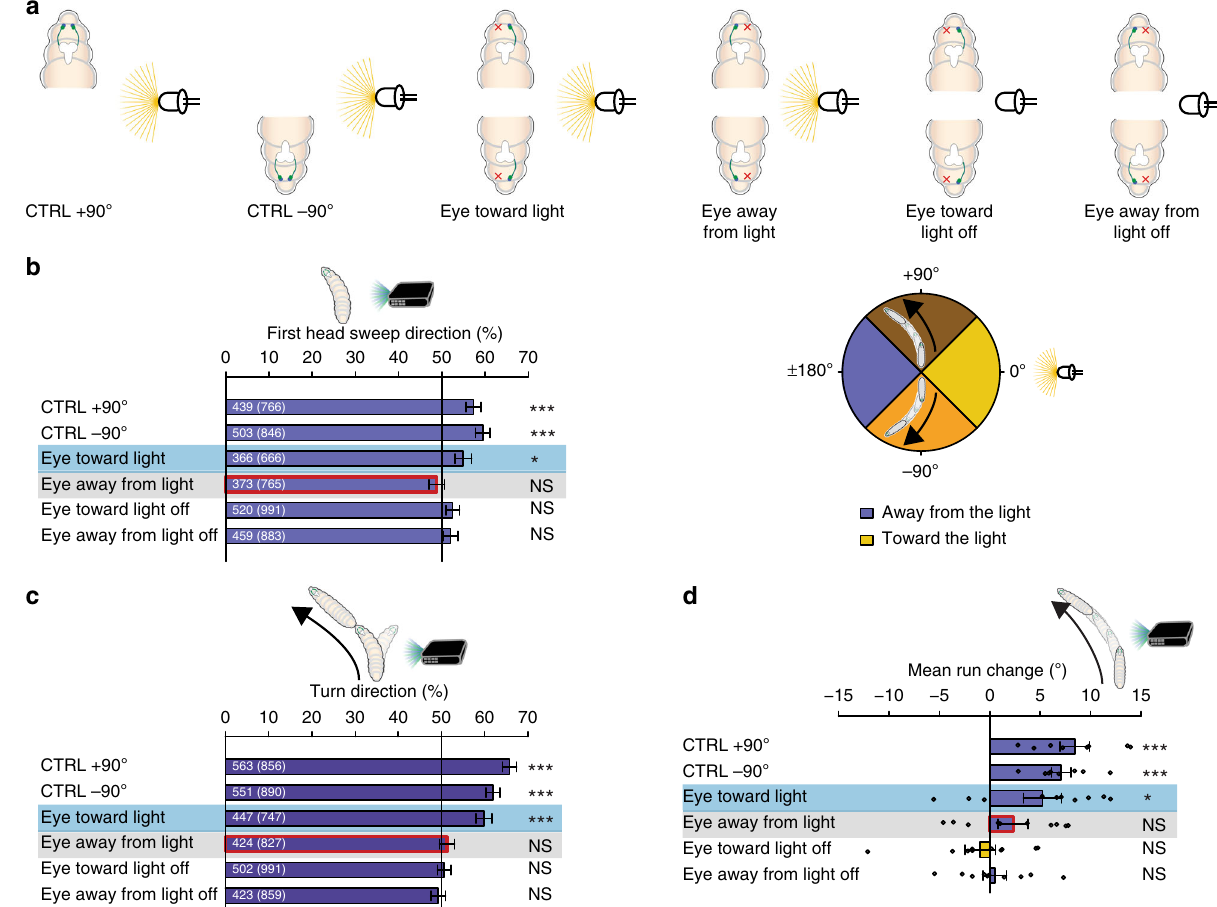
Fig. 3 Drosophila larvae use navigational strategies based on spatial information integration to avoid a directional light source. a In dependence of heading direction is the light source on the ipsi- or contralateral side of the animal with respect to the functional eye of unilateral sensing larvae. b Heading to + 90° (brown) larvae should bias their movements to the left, in order to avoid the light source. Larvae, which are orientated to − 90° (orange), should bias their movements to the right to avoid the light source. Bilateral sensing animals bias their fi rst head sweep direction away from the light source, independently of their initial heading direction. Larvae with their functional eye on the body side facing the light source bias their fi rst head sweep direction, but not when the functional eye is on the side facing away from the light source. These animals do not bias their fi rst head sweep to any direction in constant darkness. CTRL + 90°: n = 766, p = 1.8 × 10 − 4 ; CTRL − 90°: n = 846, p = 2.5 × 10 − 7 ; eye toward light: n = 666, p = 0.0234; eye away from light: n = 765, p = 0.5152; eye toward light off: n = 991, p = 0.1910; eye away from light off: n = 883, p = 0.303. c Being perpendicular to a light source, bilateral sensing animals bias their turn direction away from the light. Unilateral sensing larvae need the remaining eye on the body side toward the light, in order to bias the turn direction. CTRL + 90°: n = 856, p = 1.3 × 10 − 15 ; CTRL − 90°: n = 890, p = 3.6 × 10 − 12 ; eye toward light: n = 747, p = 1.7 × 10 − 12 ; eye away from light: n = 827, p = 0.7031; eye toward light off: n = 991, p = 0.7031; eye away from light off: n = 859, p = 0.7031. d Larvae steer within runs away from the light source. Unilateral sensing larvae need the functional eye facing toward the light source to bias this steering in runs. CTRL + 90°: n = 8, p = 5.2 × 10 − 4 ; CTRL − 90°: n = 8, p = 5.2 × 10 − 4 ; eye toward light: n = 10, p = 0.0442; eye away from light: n = 10, p = 0.2292; eye toward light off: n = 10, p = 0.6494; eye away from light off: n = 10, p = 0.673. The data are represented as mean ± SEM. For statistical analysis the exact binomial test ( b , c ) and the one sample t -test ( d ) was applied. Benjamini Hochberg procedure was used to adjust p -values for multiple testing. Exact F -values, t -values and degrees of freedom can be found in Supplementary Table 1. b The fi rst number gives the number of fi rst head sweeps directed to the indicated direction (please see color code) and the number in brackets is the total number of fi rst head sweeps in both directions. c The fi rst number indicates the number of turns in the indicated direction and the number in brackets is the total number of turns in both directions. d Circles show means of individual experiments. * p < 0.05, *** p < 0.001, n =